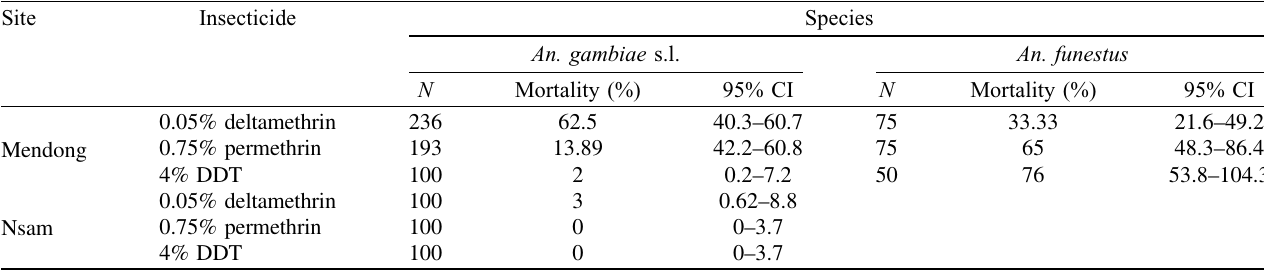
Table 7. Mortality rates for An. gambiae s.l. and An. funestus fi eld populations after exposure to 4% DDT, 0.75% permethrin, and 0.05% deltamethrin in Mendong and